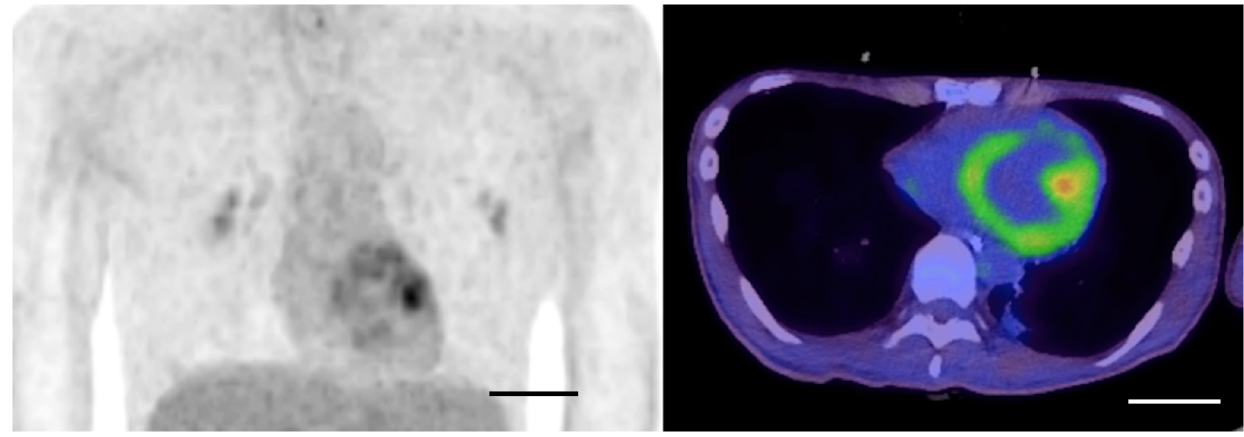
Figure 1. 18 F-fluorodeoxyglucose positron emission tomography. 18 F-fluorodeoxyglucose positron emission tomography showed heterogeneous 18 F-FDG uptake in left ventricle. Scale bar: